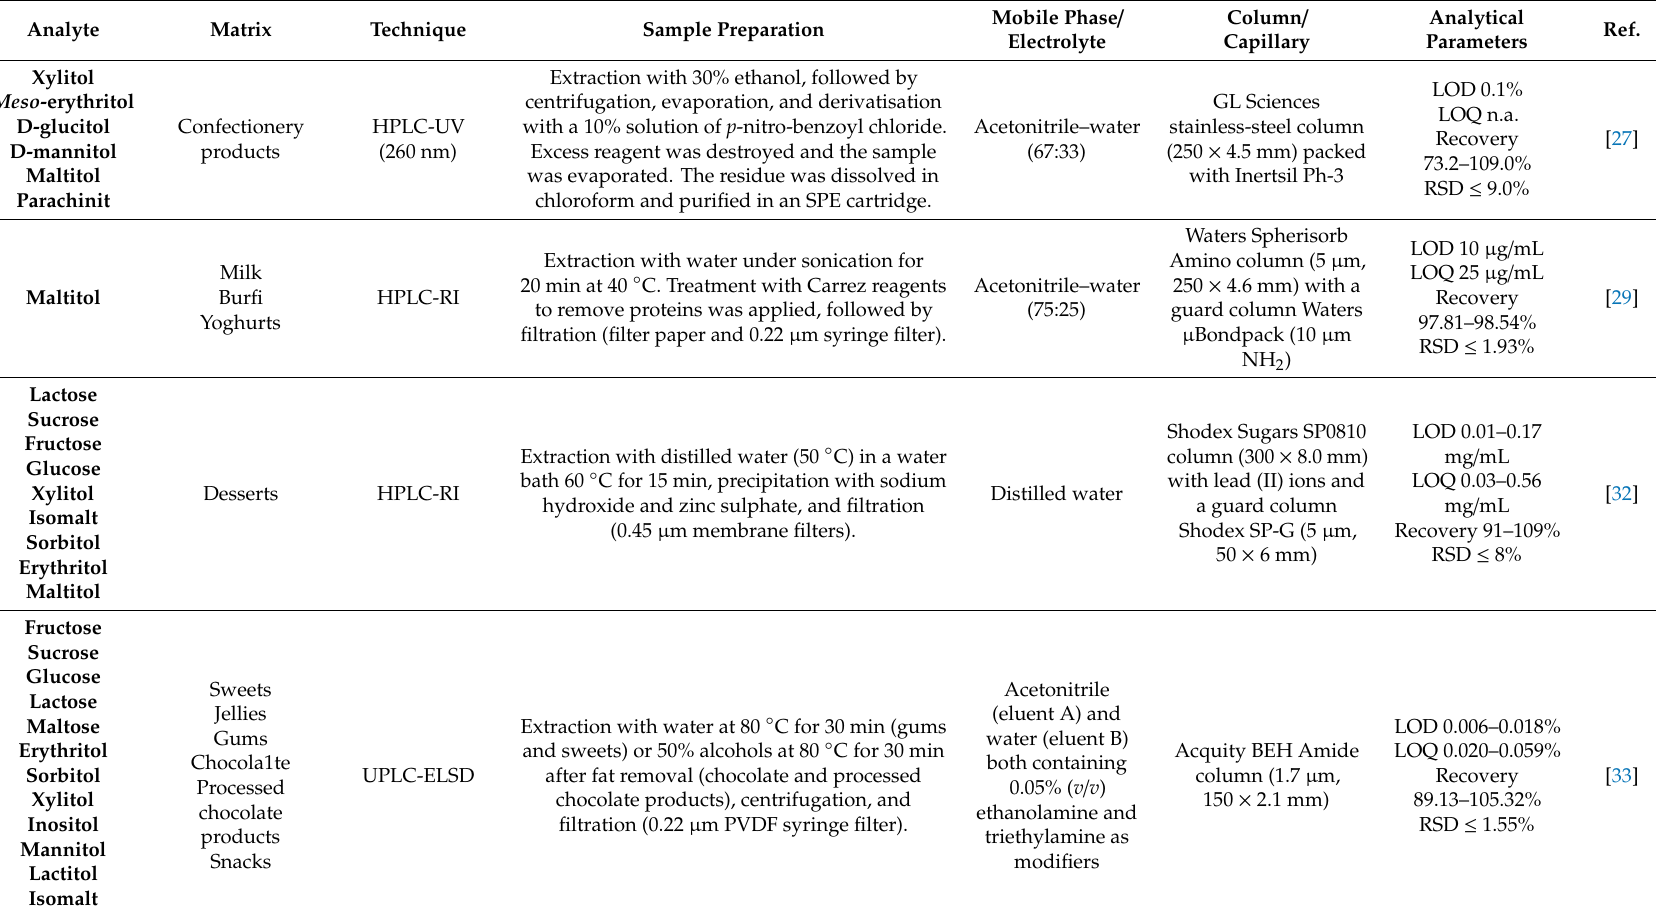
Table 1. Analytical procedures used in the determination of maltitol in food